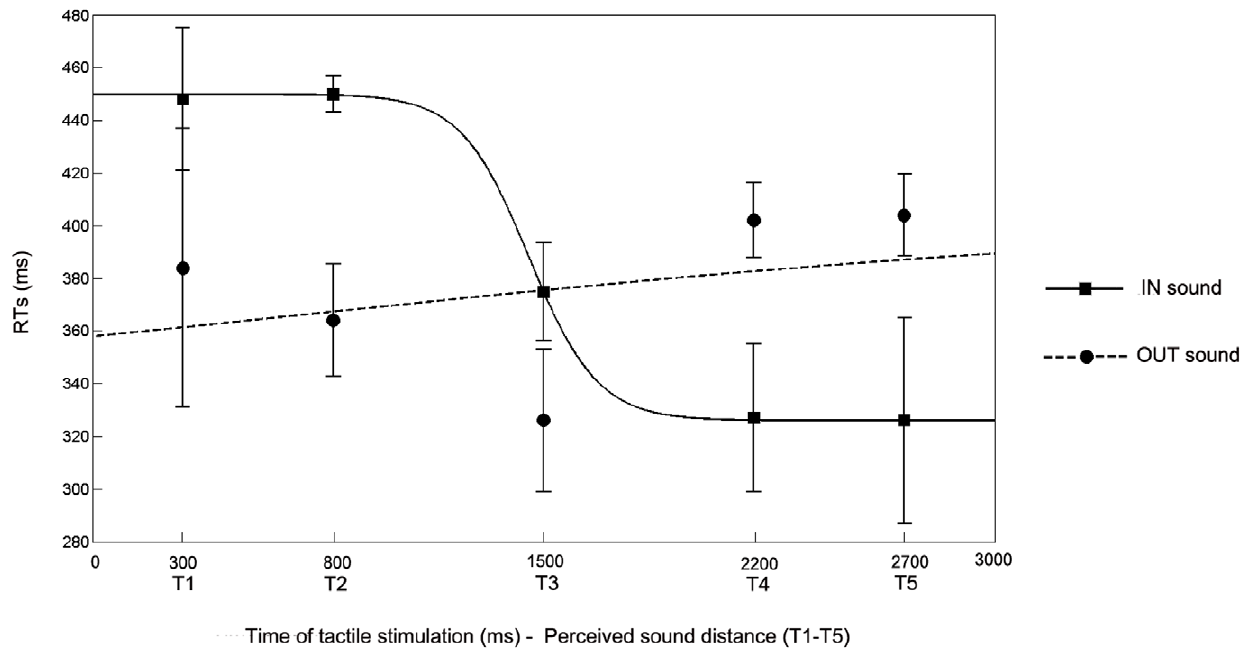
Figure 3. Best fitting function for the relationship between sound position in space and tactile processing. Data from a paradigmatic subject are reported. Figure 3 plots mean RTs (and S.E.M.) at different times of tactile stimulus delivery and the best fitting sigmoidal functions for IN (filled line) and OUT (hatched line) sounds. doi:10.1371/journal.pone.0044306.g003 PLOS ONE |